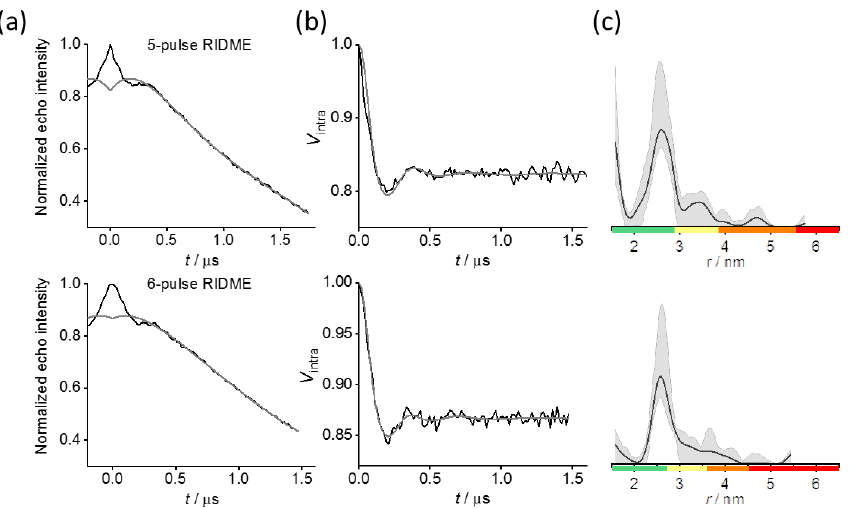
Figure 3. Q-band RIDME on 10 μM solution of 1 at 30 K. ( a ) Primary data with the gray line indicating the background decay, ( b ) background-corrected data with the gray line indicating the fit, ( c ) distance distributions (black lines) with confidence intervals (gray shadowed areas) and reliability (colored bar below the distance distributions). The experiments are indicated in the first row and the experimental parameters are given in Table S3, Supplementary Materials. Number of scans from top to bottom 141 and 90.